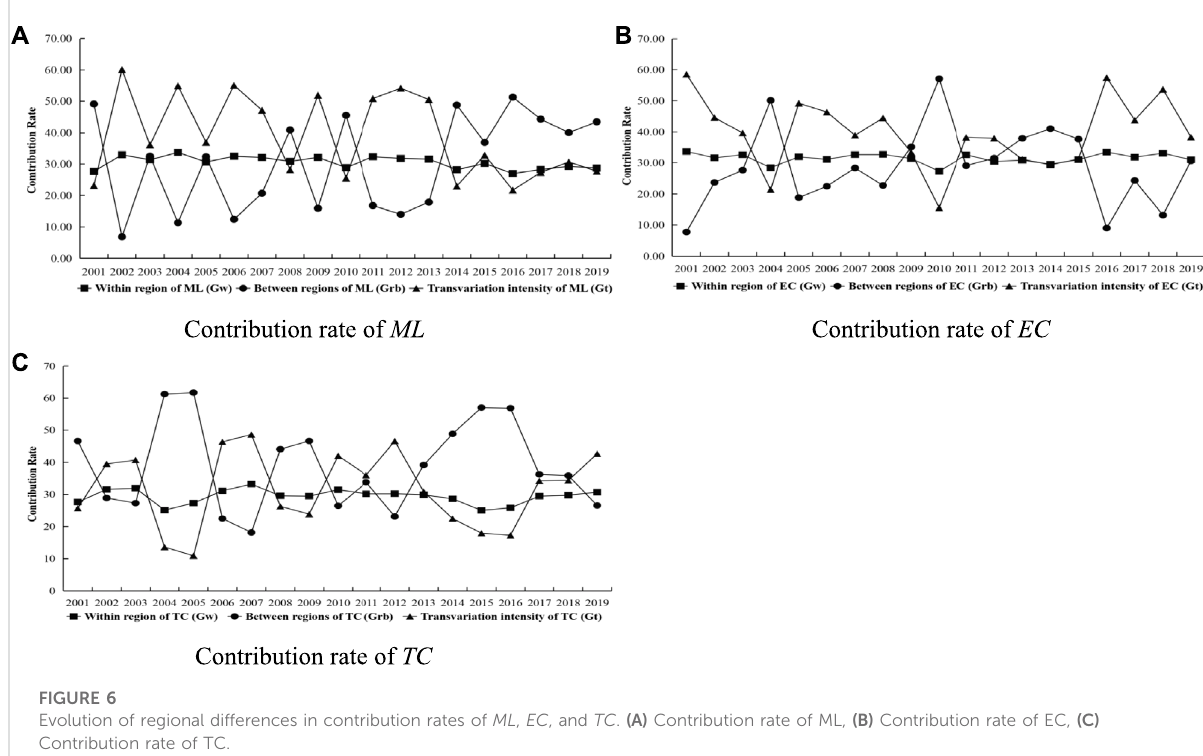
FIGURE 6 Evolution of regional differences in contribution rates of ML , EC , and TC . (A) Contribution rate of ML, (B) Contribution rate of EC, (C) Contribution rate of TC.